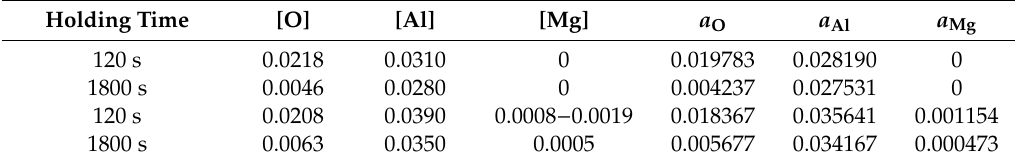
Table 7. Estimated composition of steels (weight